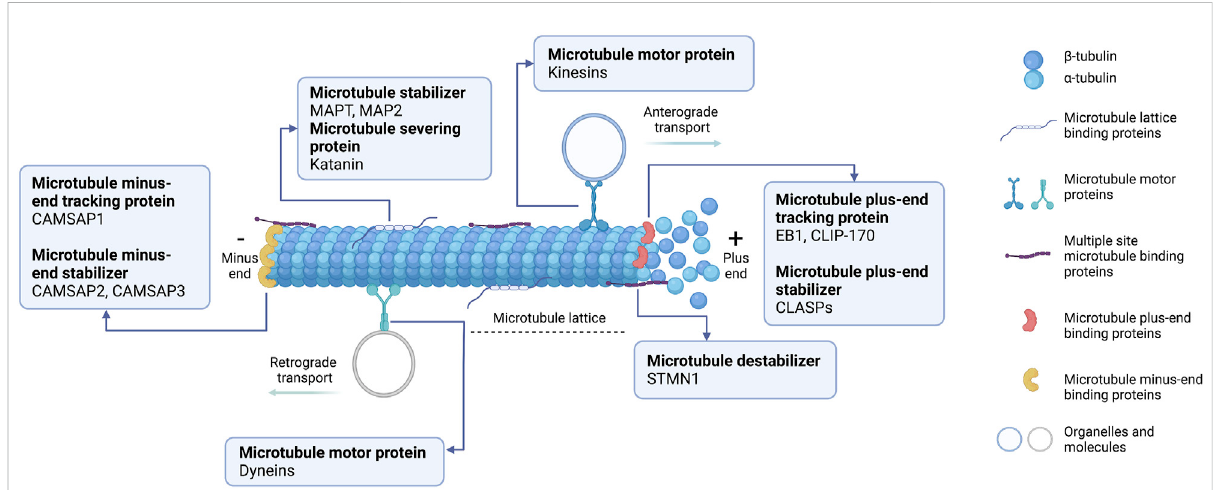
FIGURE 1 Schematic representation of microtubule-associated proteins (MAPs) binding to microtubules at different sites. (1) Microtubule lattice-binding proteins located at the middle region along the microtubule length, including MAPT and MAP2. (2) Two types of microtubule motor proteins exist: kinesins and dyneins. Kinesins carry the cellular organelle or molecules traf fi cking towards the microtubule plus-end (anterograde transport). Dyneins transport the cellular molecules to the microtubule minus-end (retrograde transport). (3) Multiple site microtubule-binding proteins, such as stathmin (STMN1), bind to several sites on microtubules. (4) Microtubule plus-end binding proteins (+TIPs) accumulate speci fi cally at the growing ends of microtubules. +TIPs can affect microtubule positioning and regulate microtubules dynamically. (5) Microtubule minus-end binding proteins are preferentially anchored at the minus-end where microtubules are stabilized. This diagram was created with “ Biorender.com ”